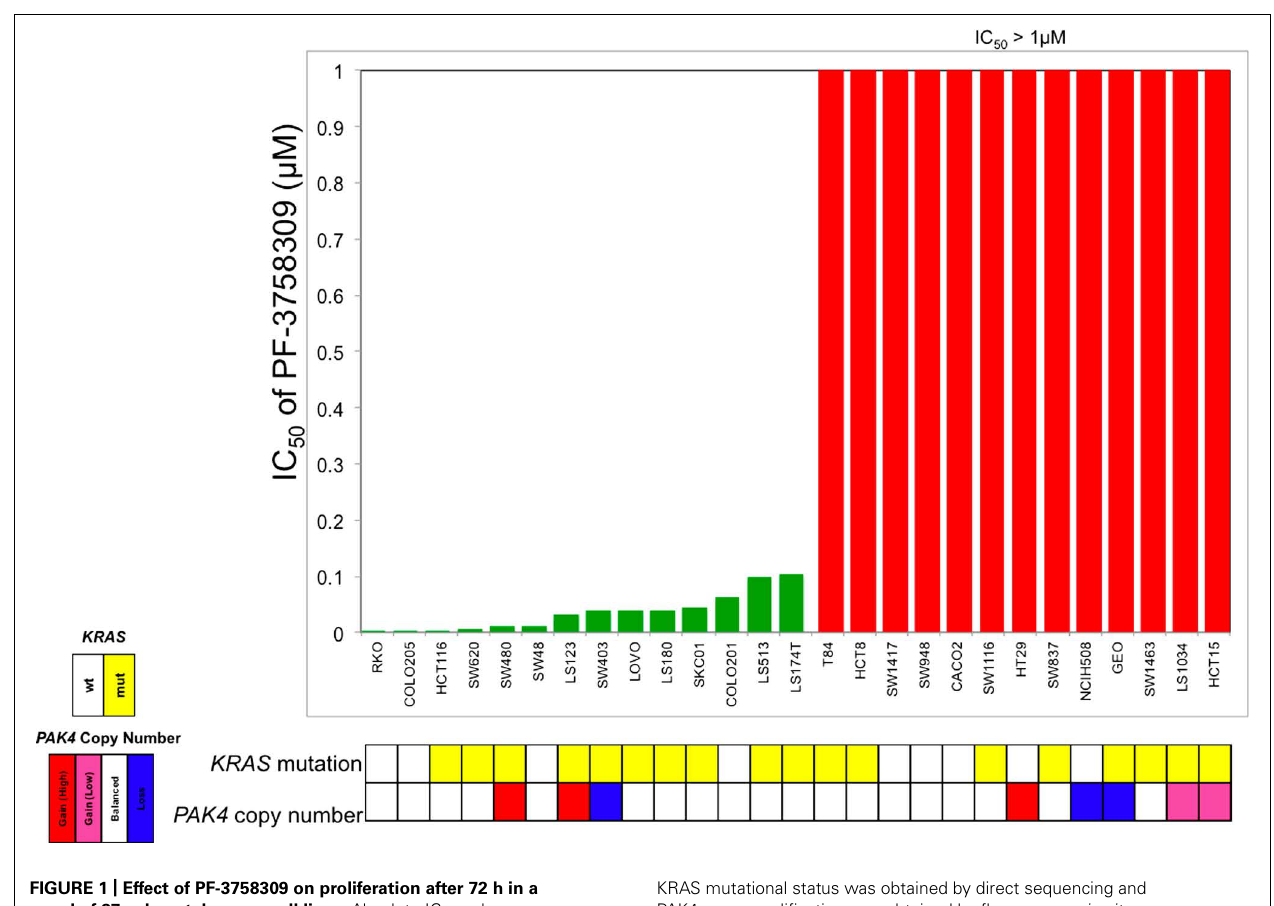
FIGURE 1 | Effect of PF-3758309 on proliferation after 72 h in a panel of 27 colorectal cancer cell lines. Absolute IC 50 values were calculated and graphed (green, sensitive; red, resistant).